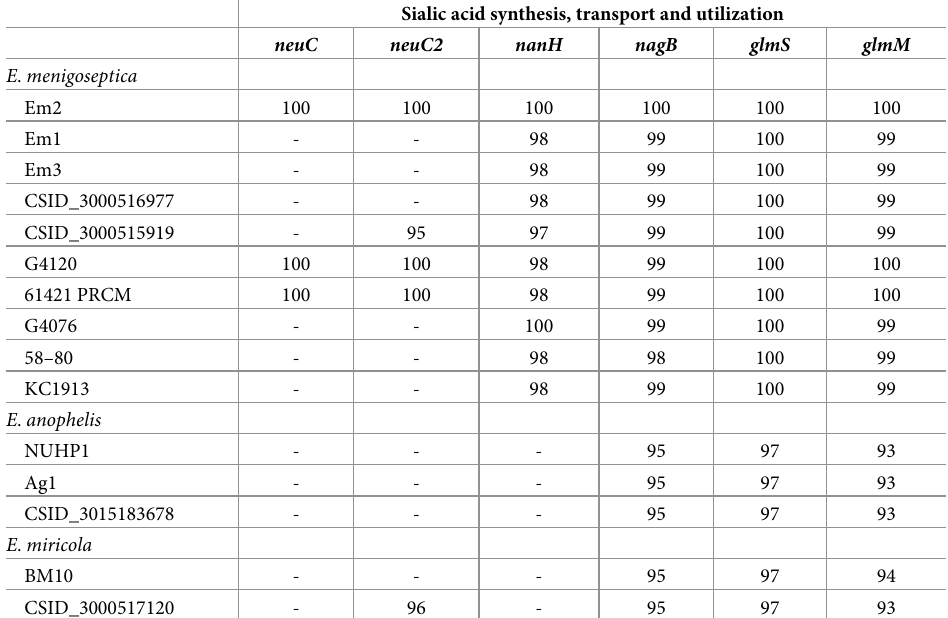
Table 5. Comparison of selected sialic acid synthesis, transport and utilization genes among Elizabethkingia � . Sialic acid synthesis, transport and utilization